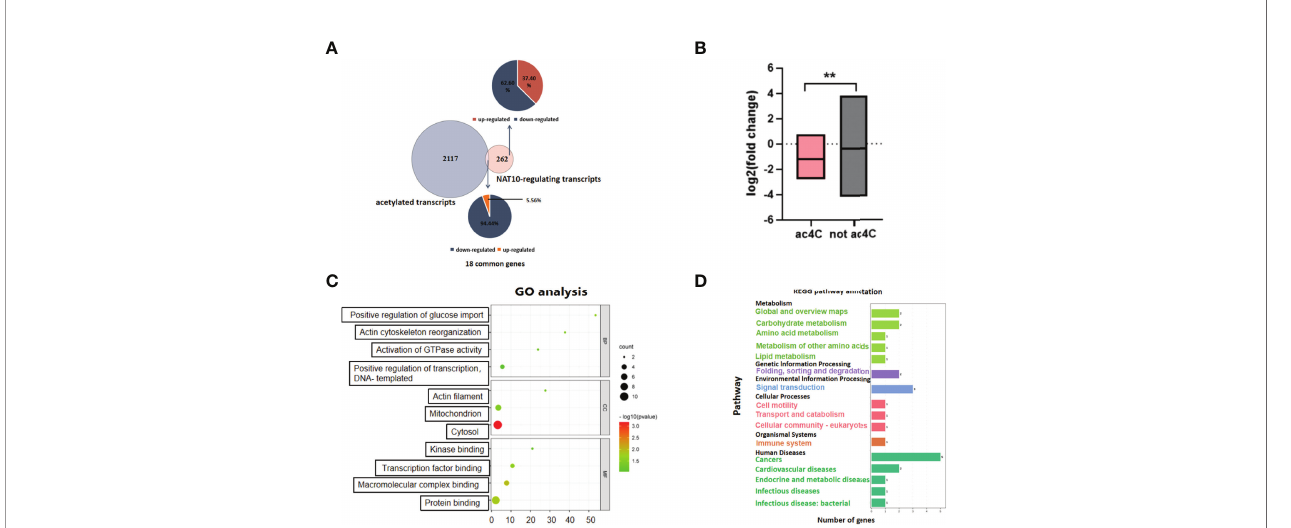
FIGURE 2 | Transcripts modulated by NAT10-mediated ac4C modi fi cation in oocytes. (A) Venn diagram and pie chart showed the proportion of NAT10-regulated ac4C genes and non – ac4C-modi fi ed genes. (B) Box diagram displayed the fold change difference between NAT10-regulated ac4C-modi fi ed DEGs and non – ac4C- modi fi ed DEGs. (C) Sixteen downregulated ac4C-modi fi ed DEGs regulated by NAT10 mainly participated in regulation of protein binding and positive regulation of transcription, DNA-templated. (D) KEGG analysis showed 16 downregulated ac4C-modi fi ed DEGs regulated by NAT10 were enriched in cancer, signal transduction, folding, sorting, and degradation. Unpaired t-test was used in (B) to compare the expression of genes because the number of genes did not match between two groups. ** P <